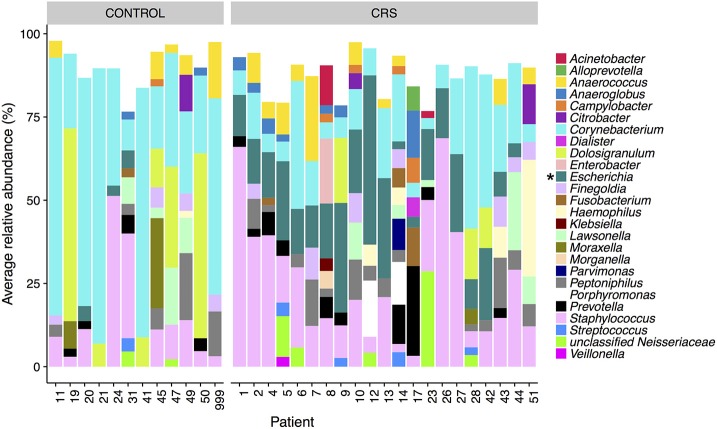
Average relative abundance of OTUs per patient colored by genus. Only sinus samples were included, and OTUs with average relative abundance of <1% were excluded. Percentages were calculated from rarefied data. Genera that were significantly different in relative abundance between CRS and controls are marked with * (Kruskal-Wallis, FDR corrected p < 0.05).